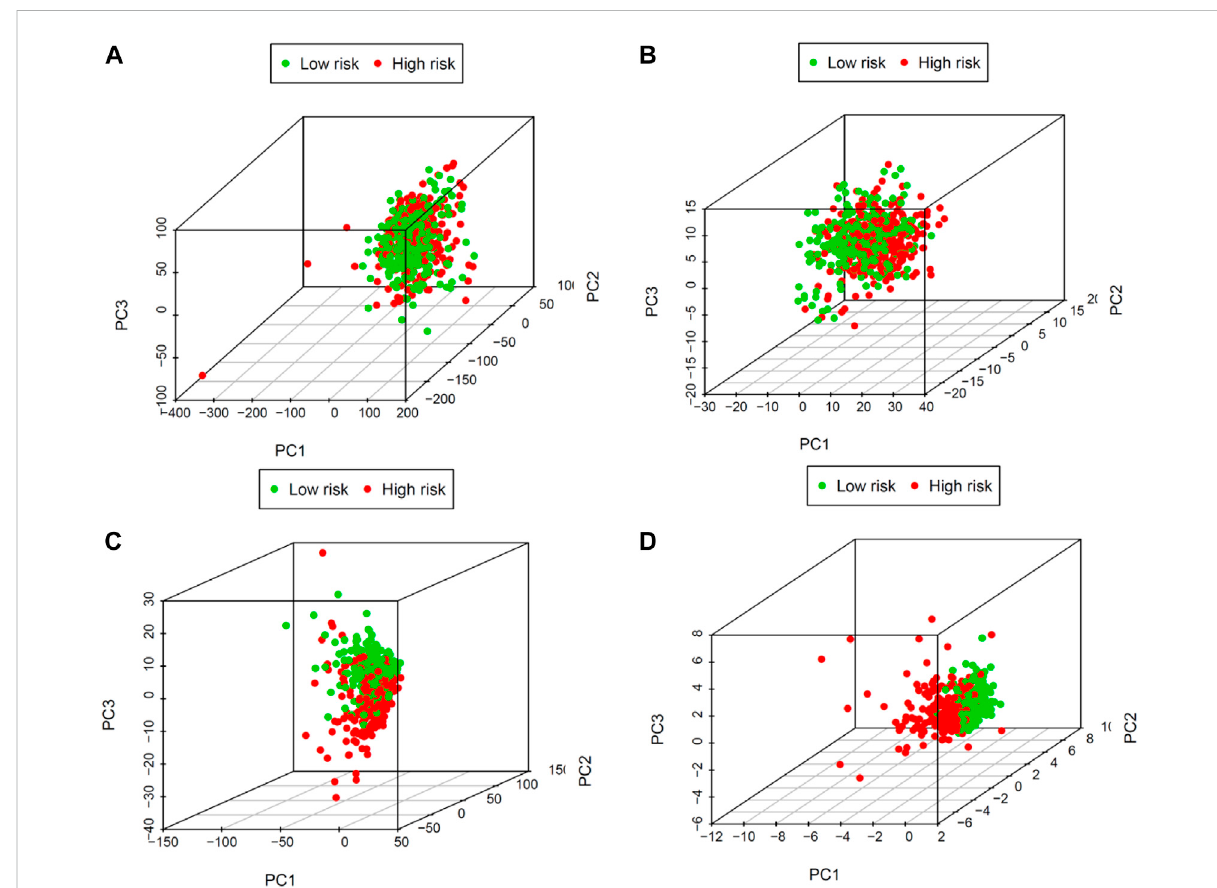
FIGURE 5 Principal components analysis between low- and high-risk groups based on (A) the entire gene expression, (B) COVID-19 genes, (C) COVID- 19 – associated lncRNAs, and (D) the risk